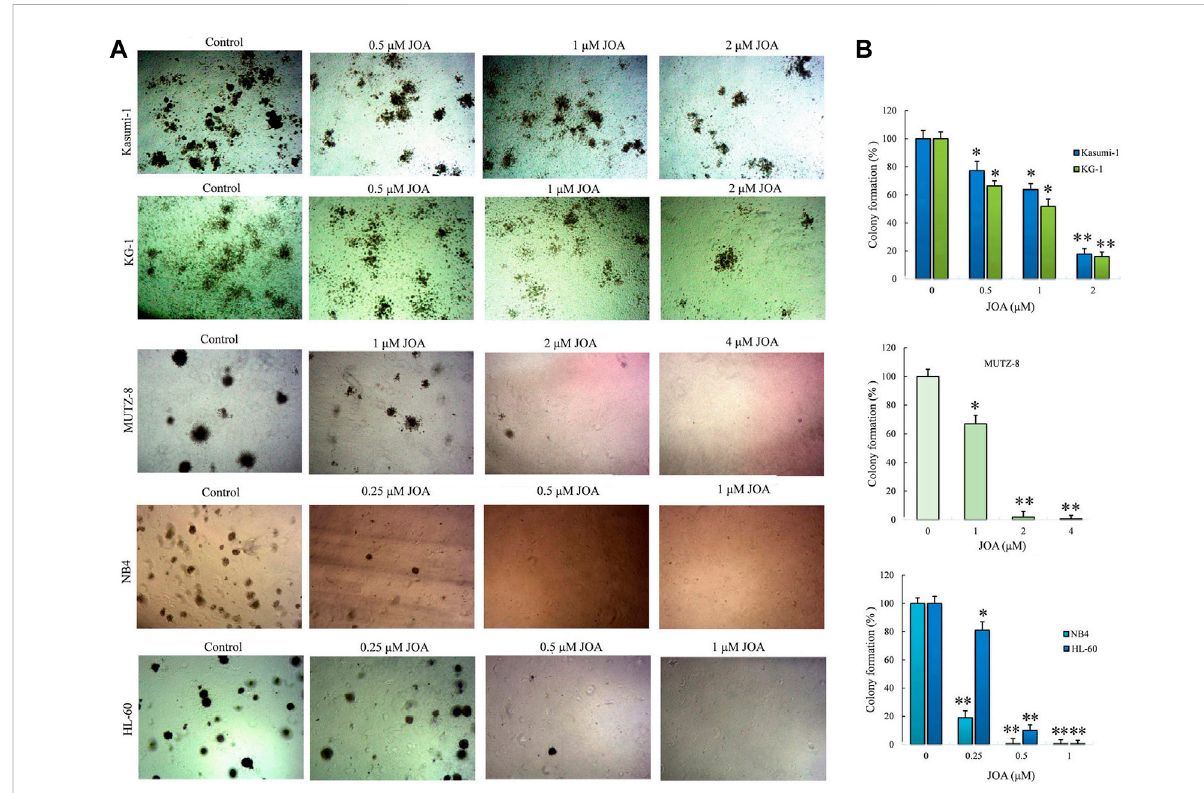
Effect of JOA on thecolony formation ability inKasumi-1, KG-1, MUTZ-8, NB4, and HL-60 cells. (A) Colony formation assay inmethylcellulose. (B) Effect of different concentrations of JOA on the number of colonies (* p < 0.05 and ** p < 0.01). Cells were incubated with JOA (0.25 – 2 µM) for 14